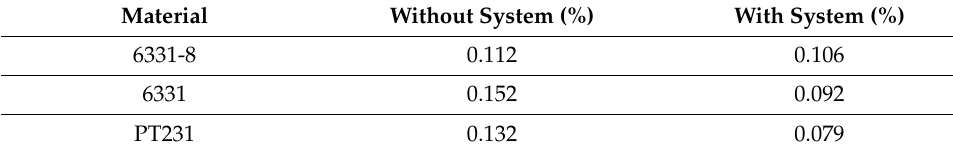
Table 7. Variation of product weight with and without the system.